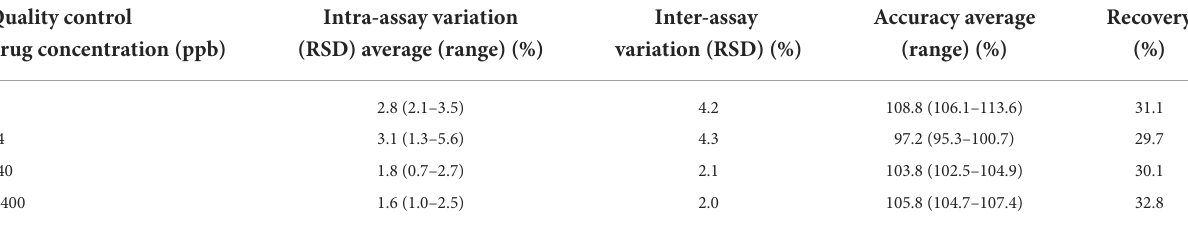
TABLE 2 Sensitivity, precision and accuracy parameters for the ultra-performance liquid chromatography with tandem mass spectrometry analytical method used to measure florfenicol amine concentrations in goat milk following florfenicol administration to lactating does. Quality